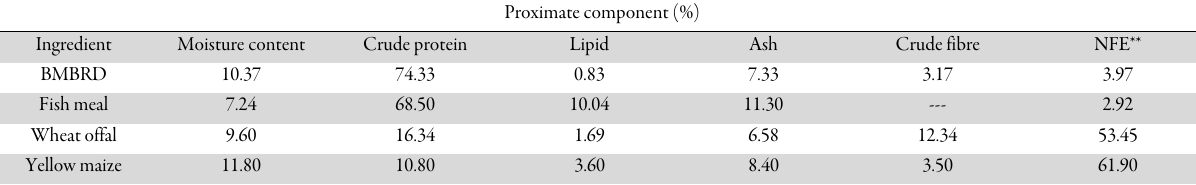
Proximate component (%)